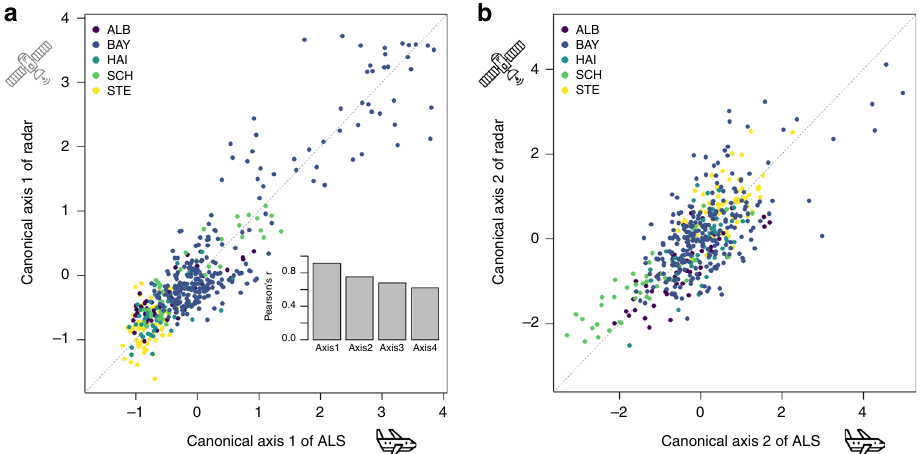
Fig. 1 Correlations between the metrics from the two sensors. Correlations between the a fi rst (forest maturity) and b second (structural heterogeneity) axes of a canonical correlation analysis, extracted to maximise the correlation between the data sets of the radar- and airborne laser scanning (ALS)- derived variables. The inset in ( a ) shows the Pearson ’ s correlation coef fi cients for the fi rst four axes of the two data sets with the signi fi cance level p < 0.001. Source data are provided as a Source Data fi